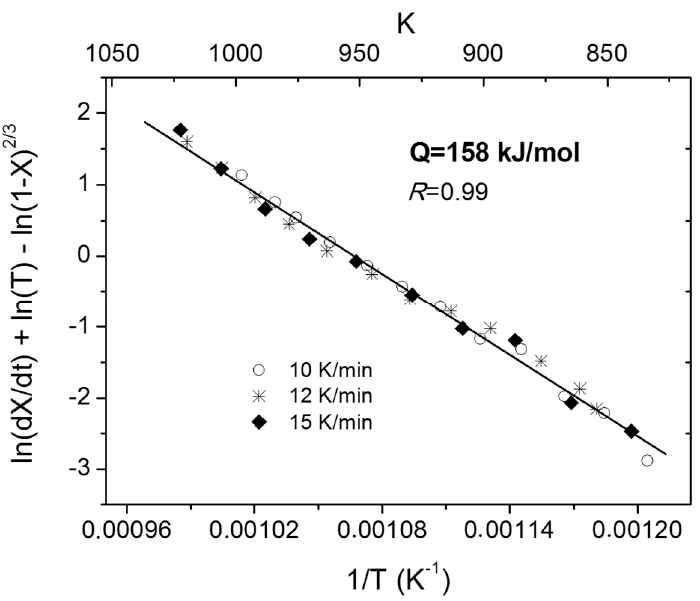
Figure 4. Arrhenius plot for the non ‐ isothermal reduction of shallow powder beds of Fe 2 MoO 4 [2].